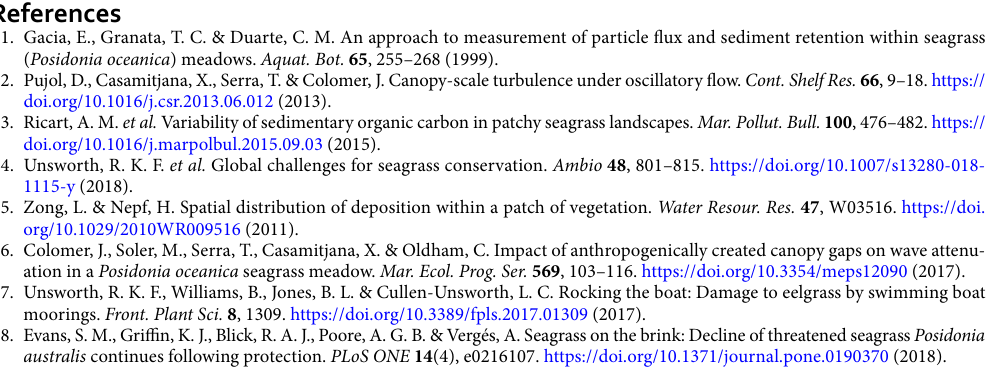
To obtain a more complete model the experiments from Zhang et al. 20 , Barcelona et al. 29 and Pujol et al. 16 were added to the comparison (Table